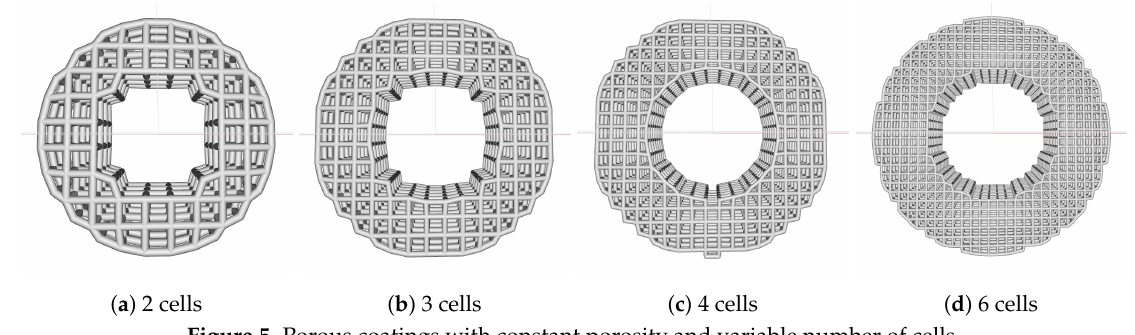
Figure 5. Porous coatings with constant porosity and variable number of cells.